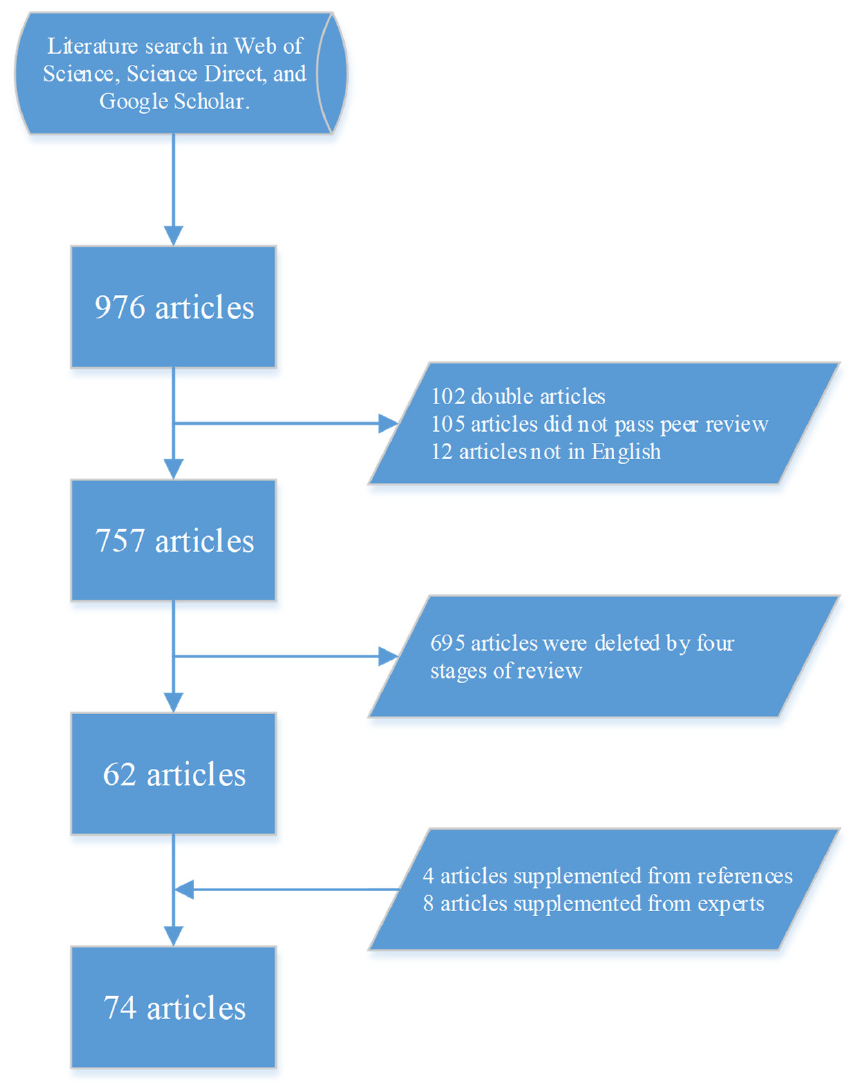
Figure 1. Literature search process .